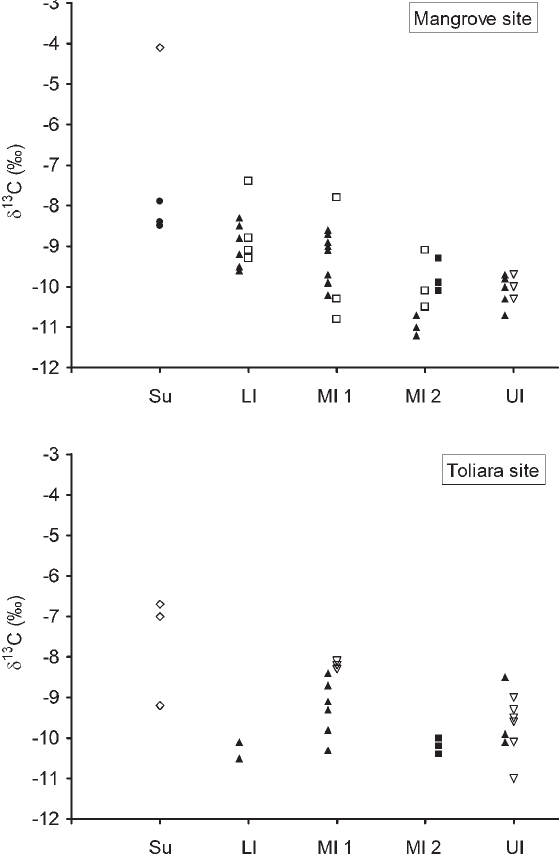
Fig . 5. – relation between δ 15 n and nitrogen concentrations in leaves of Halodule sp. ( p ) Halophila ovalis ( s ) and Thalassia hemprichii ( £ ) collected on toliara Beach and Beloza mangrove